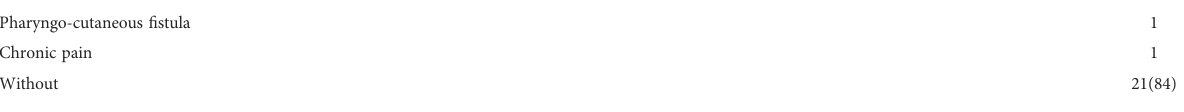
Table 2. The mean overall QOL score prior to SS was